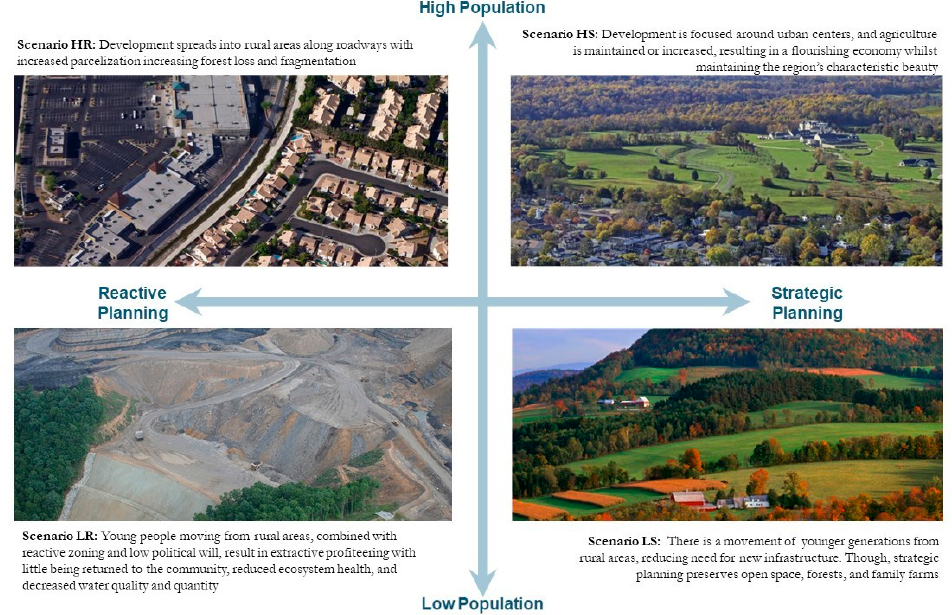
Figure 2. Schematic of the four quadrants defining our scenario plans along population growth and strategic planning gradients for the CLI study area in northern Virginia.